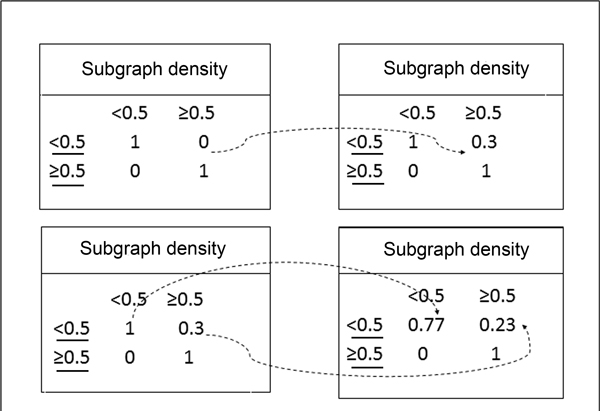
Crossover operation for the example FCFM.